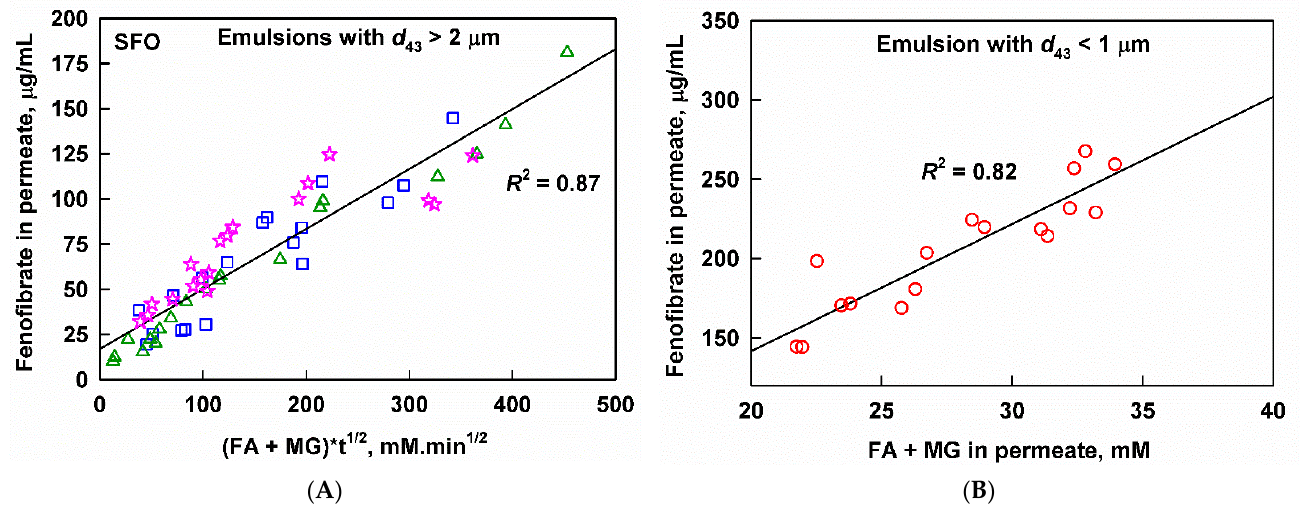
Figure 9. Aqueous fenofibrate as a function of ( A ) the sum of fatty acids (FA) and monoglycerides (MG) measured in the aqueous phase multiplied by t 1/2 for microscale SFO emulsions with d 43 = 0.7 µm (10 wt% emulsifier, red circles), d 43 = 2.2 µm (1 wt% emulsifier, blue squares) and d 43 = 11.8 µm (10 wt% emulsifier, pink stars), and ( B ) the sum of fatty acids (FA) and monoglycerides (MG) measured in the aqueous phase for the nanoscale SFO emulsion with d 43 = 0.7 µm (red circles). Individual (non-averaged) data points are plotted.